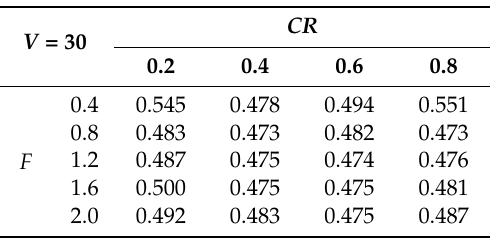
Table A2. The average fitness of the population, over 5 trials, for V = 30, and for different combinations of CR and F .